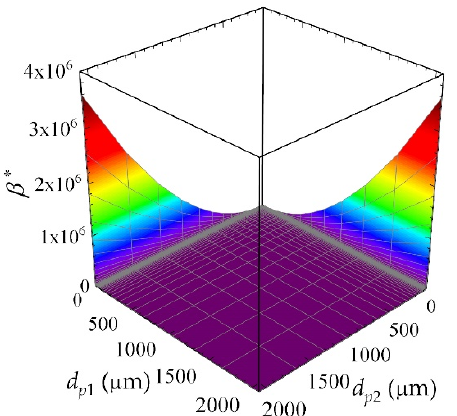
Figure 5. 3D representation of the particle size dependent part β *( d p 1 , d p 2 ) of the equipartition kinetic energy (EKE) kernel.